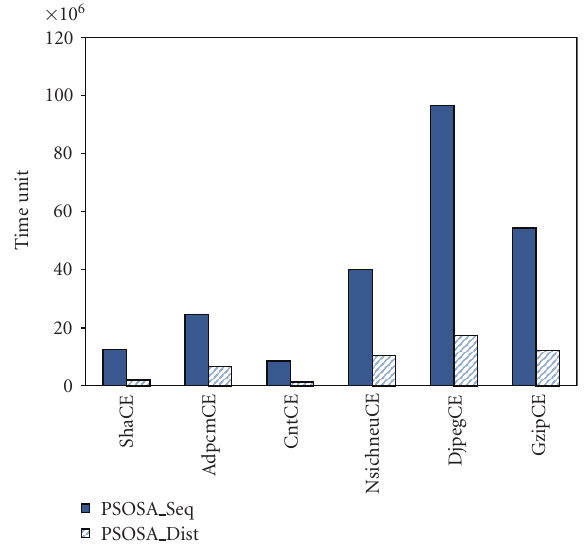
Figure 4: Execution time used by HPSO-SA algorithms on bench- marks studied in this